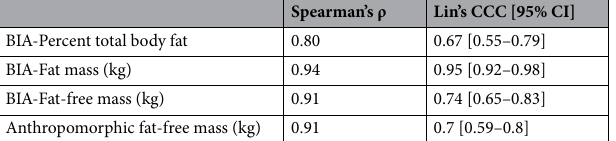
Correlations by regional percent body fat.